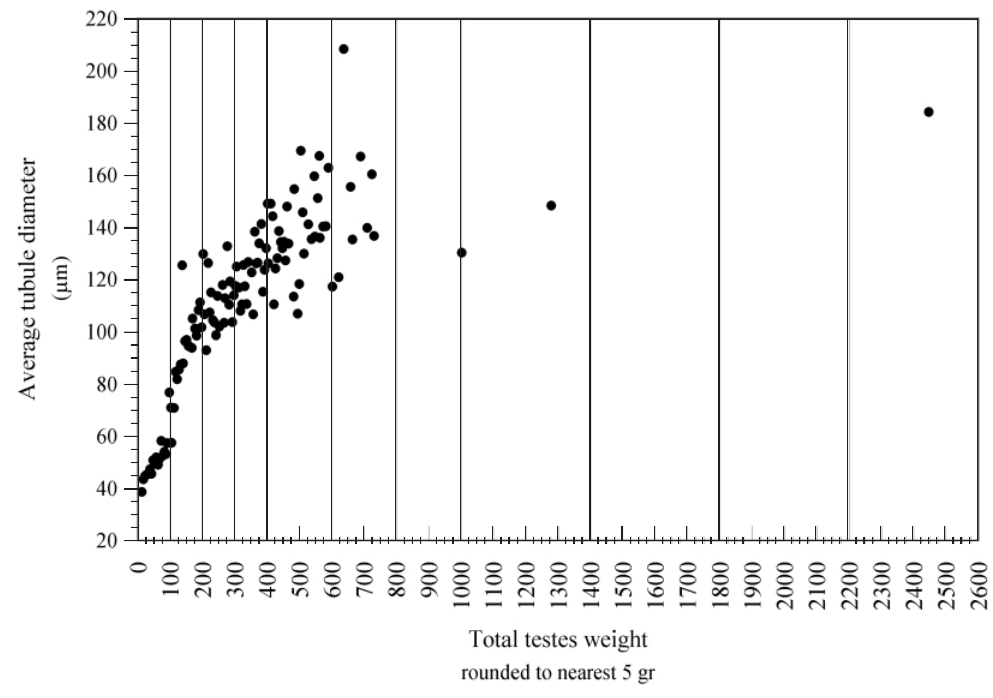
Fig. 3. Relationship between aver- age semini- ferous tubule diameter and combined testis weight.